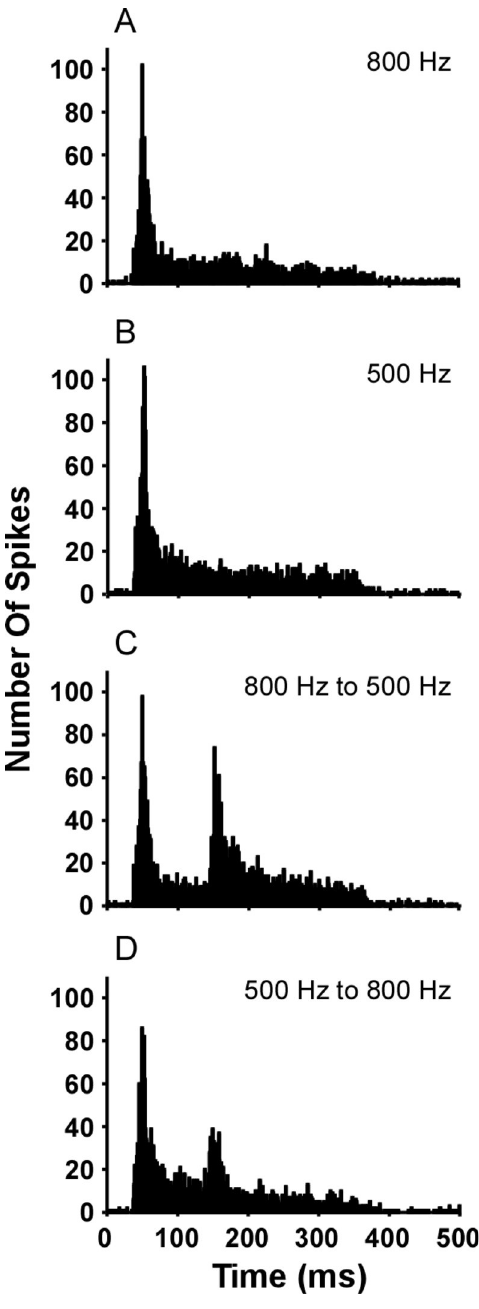
Fig 7. Peristimulus time histograms for responses of cells to tones and FM steps. Each cell completed 20 repetitions of the four stimuli, presented in pseudorandom order. Stimuli were: (A) 800 Hz tone; (B) 500 Hz tone; (C) 800 Hz to 500 Hz step FM; D) 500 Hz to 800 Hz step FM. Downward FM elicits a large mid-stimulus response, less so for upward FM, and not evident for tones. All stimuli had 325 ms duration and the natural whine envelope (Fig 1). The FM step transition is 109 ms after stimulus onset (at 25 ms). Histogram bin width is 1 ms. N = 52 cells.